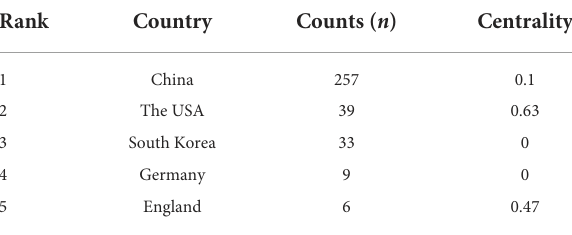
TABLE 1 Top five countries/regions with the number of published articles. Rank